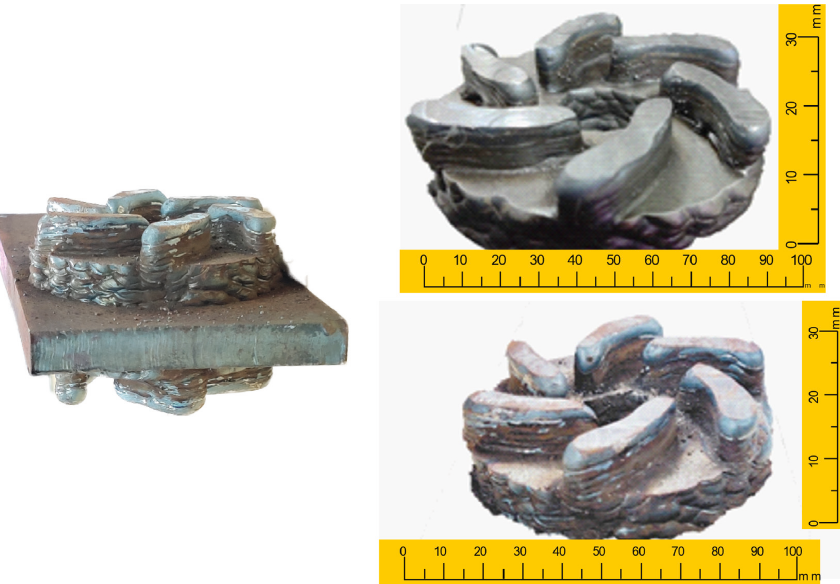
Figure 29: Near-net shape of the impellers deposited with integrated substrate method.